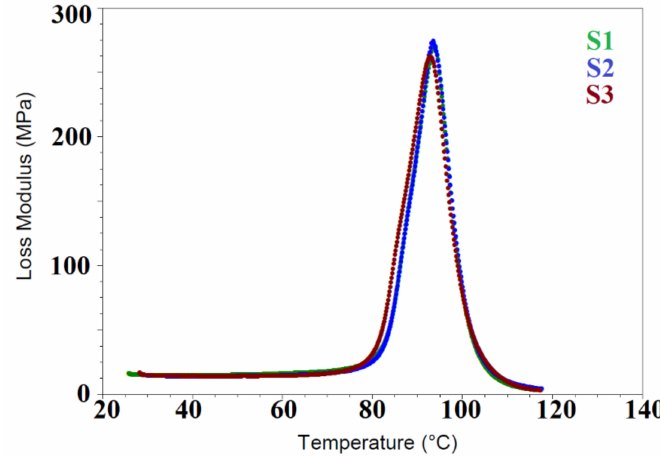
Figure 4. Loss modulus of sol-gel silica materials deposited onto PVC substrate. Table 2. Modulus values of PVC substrate covered with thin films of sol-gel silica materials.